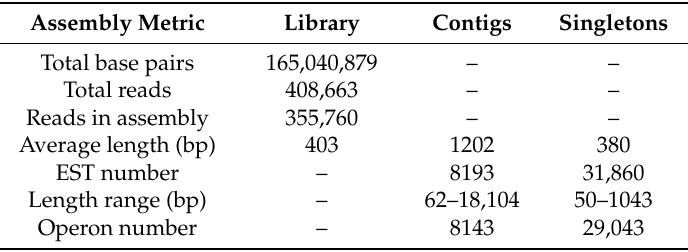
Table 1. Assembly of the M. enterolobii